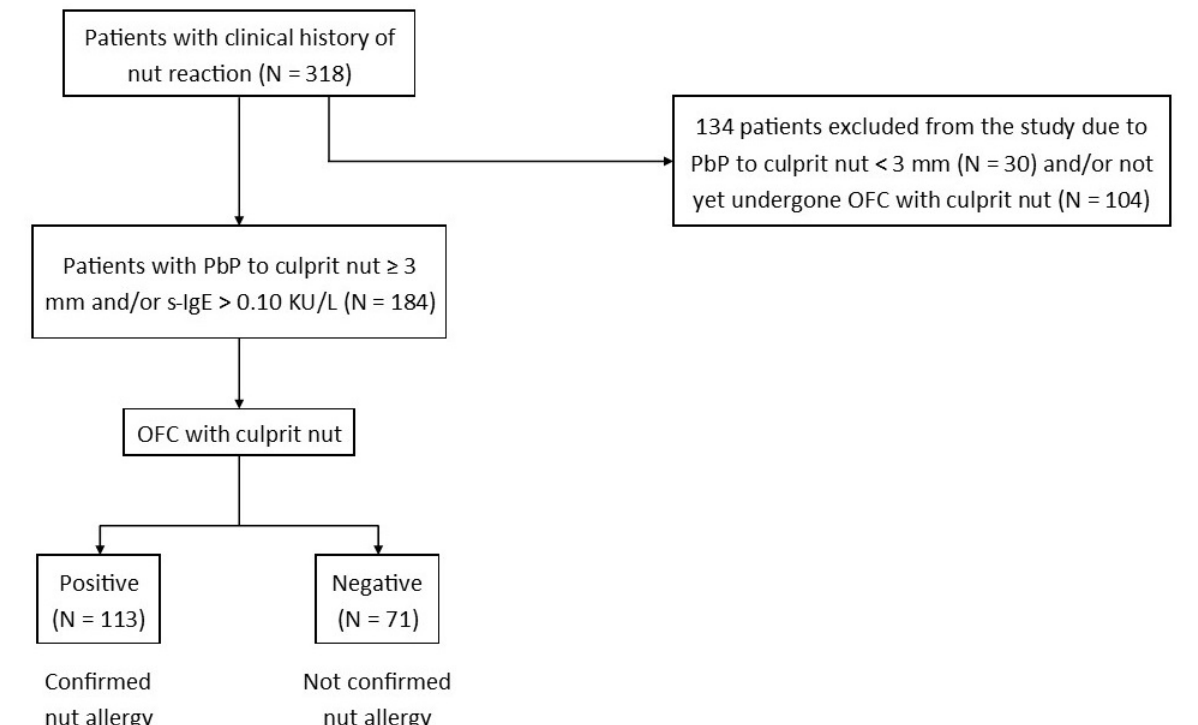
Figure 1. Flow chart used for the diagnostic selection of children with a confirmed nut allergy. Legend: N, number; OFC, oral food challenge; PbP, prick by prick; s-IgE, serum-specific IgE.